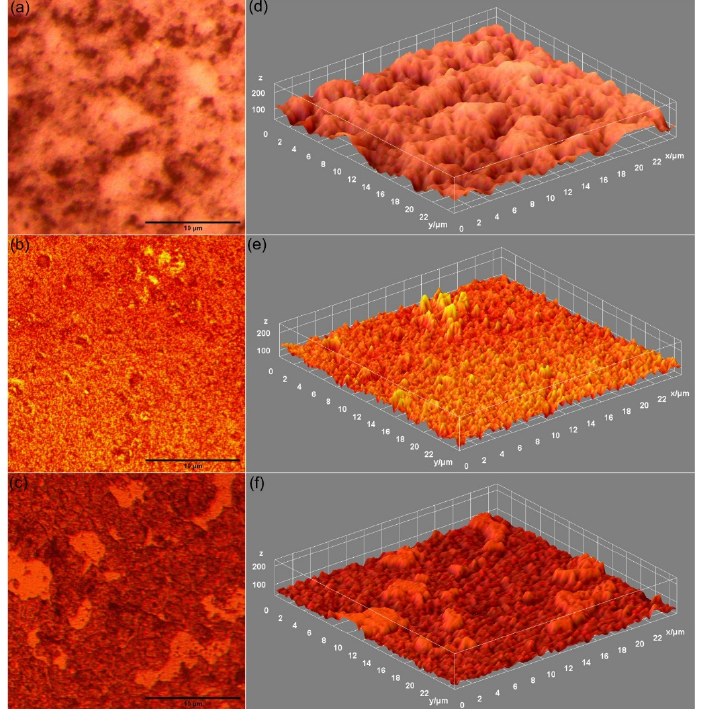
Figure 5. Images in 2D and 3D obtained by metallographic studies on ZnHApC ( a , d ), ZnHApC-7D ( b , e ), and ZnHApC-14D ( c , f )